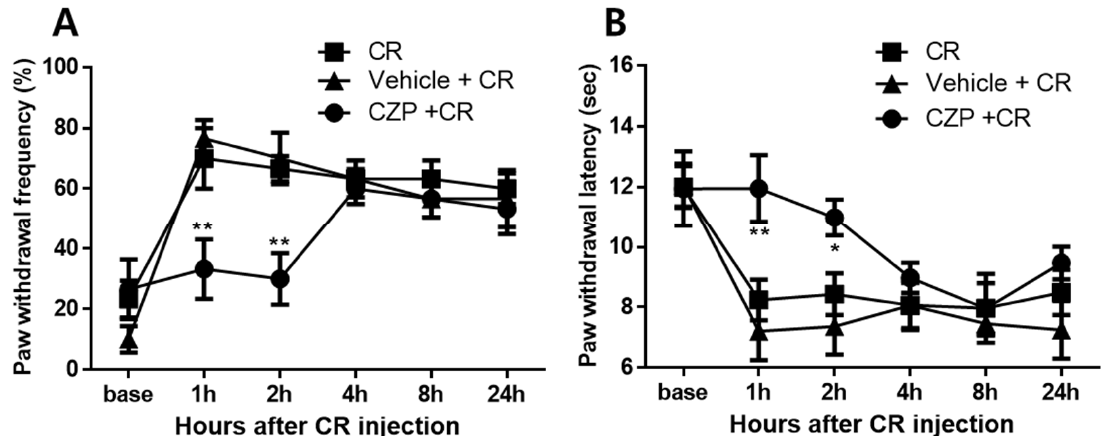
Figure 3. Graphs show the anti-nociceptive effects of intrathecal administration of 1 µ g of capsazepine on mechanical allodynia ( A ) and thermal hyperalgesia ( B ) in mice with carrageenan-induced inflammatory pain. Carrageenan-induced mechanical allodynia at 1 and 2 h was significantly suppressed in the capsazepine-administered group (CZP + CR, n = 8) compared to that in mice with carrageenan-induced inflammatory pain (CR, n = 8, *** p < 0.001). For thermal hyperalgesia, paw withdrawal latency increased from 1 to 2 h after carrageenan injection compared to that in carrageenan-injected mice (* p < 0.05, ** p < 0.01). No significant differences in paw withdrawal frequency (%) and paw withdrawal latency (sec) were observed between the vehicle group (Vehicle + CR, n = 8) and 2% carrageenan-injected animals at all timepoints of behavioral measurement.